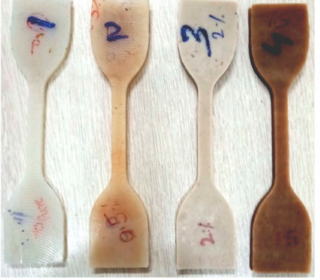
Figure 2. Samples prepared for tensile testing.